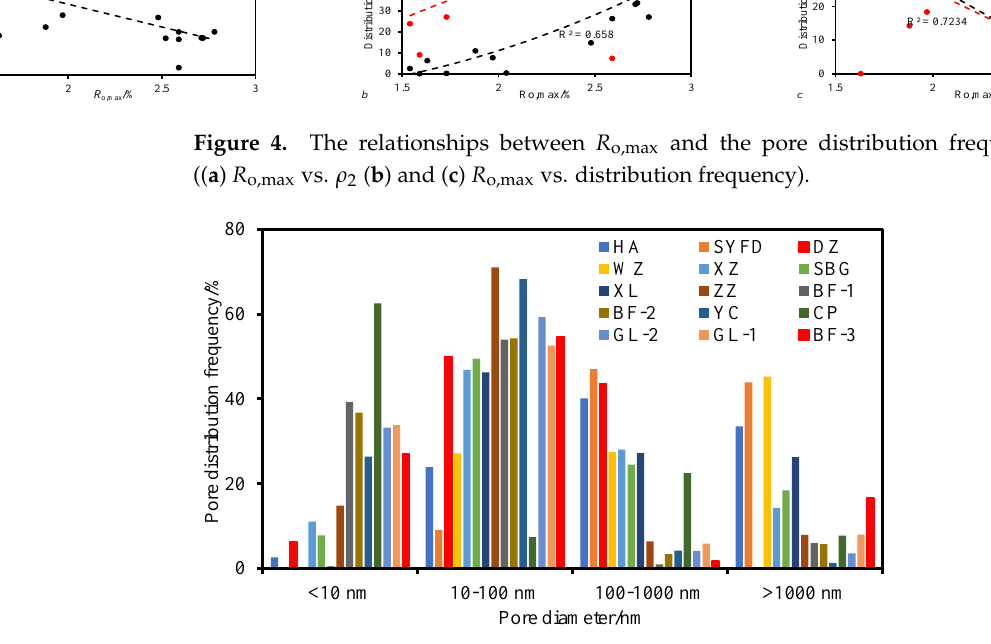
Figure 5. The pore distribution frequency of middle-high rank coals by NMR.